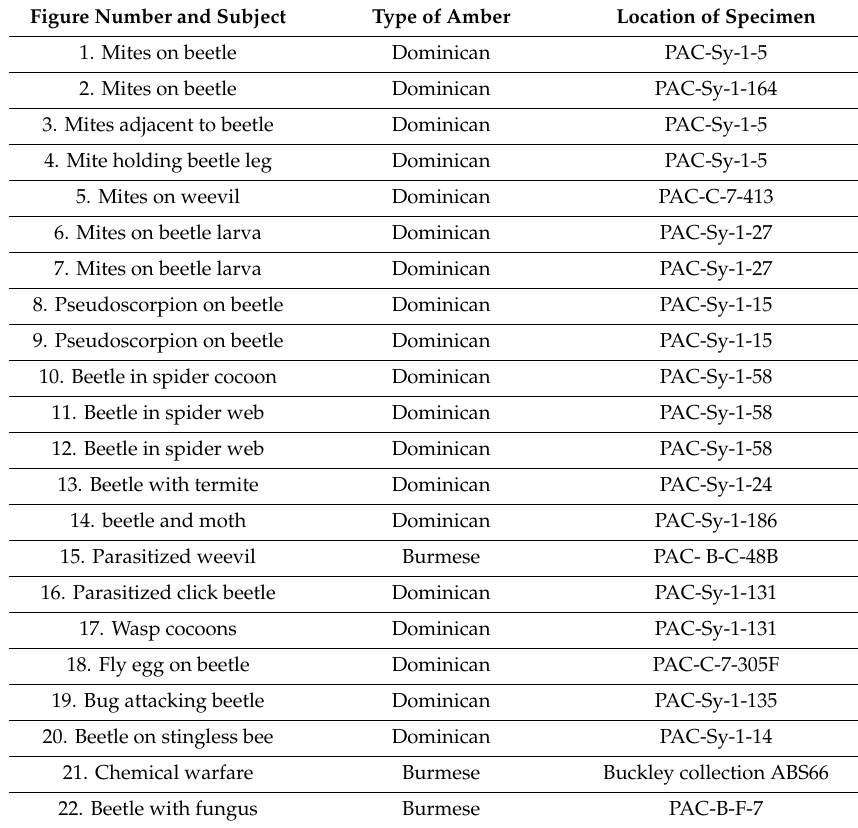
Table 2. Location of specimens figured in the present review. PAC = Poinar amber collection, maintained at Oregon State University, Corvallis, Oregon,